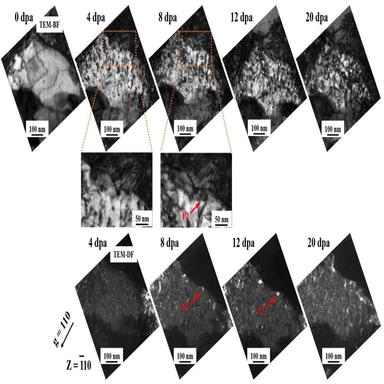
In-situ TEM observation revealing the formation of a carbide (labeled as P2 in) occurring between 4 and 8 dpa at 440 °C. Sequential TEM-BF images also showing the evolution of dislocation loops formed under irradiation. (two columns wide).